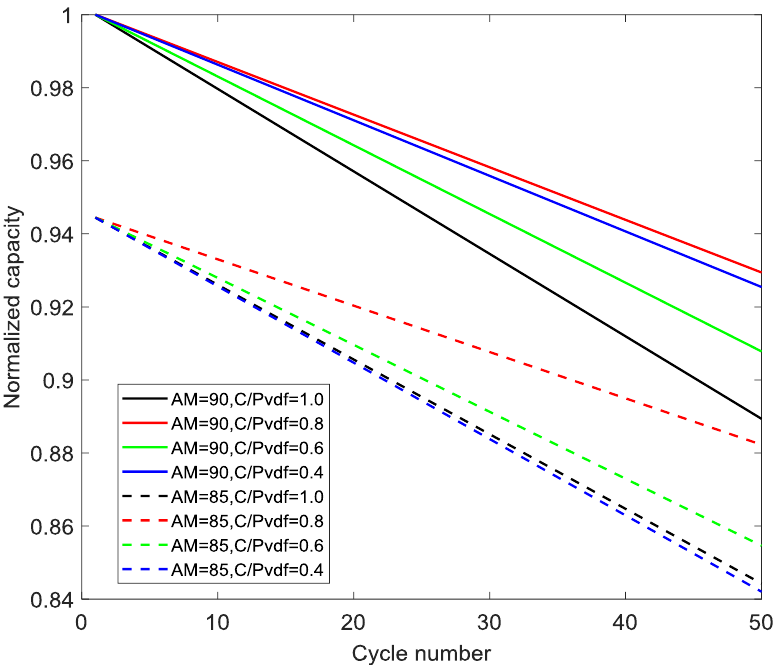
Figure 12. Normalized capacity for different samples.